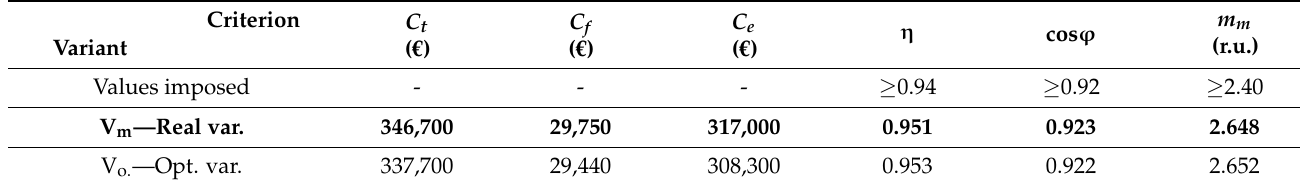
Table 3. The values obtained for the analyzed